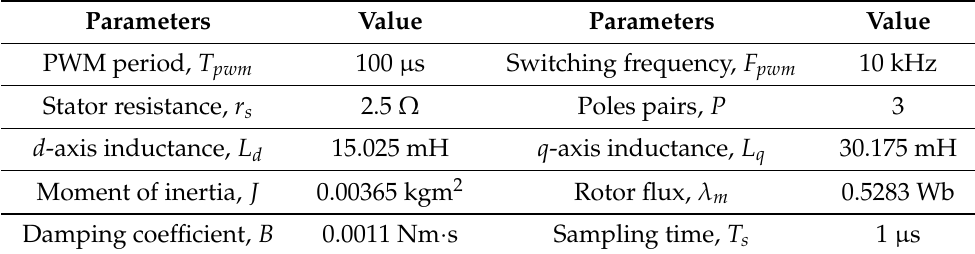
Table 1. Control System